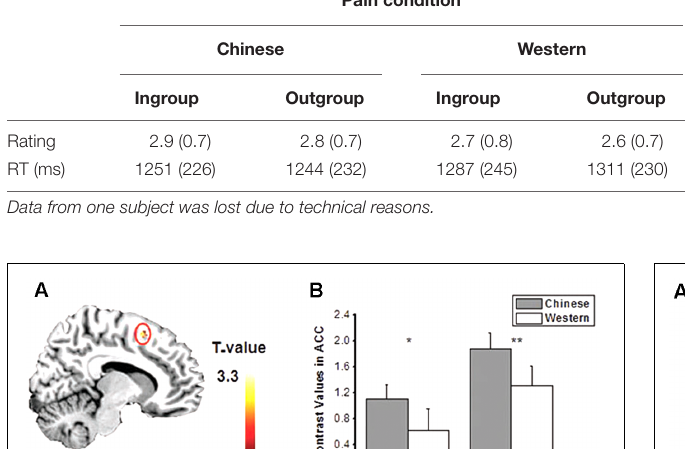
TABLE 2 | Mean rating scores (SD) of pain intensity and reaction time (RT) during fMRI scanning ( N = 28). Pain condition